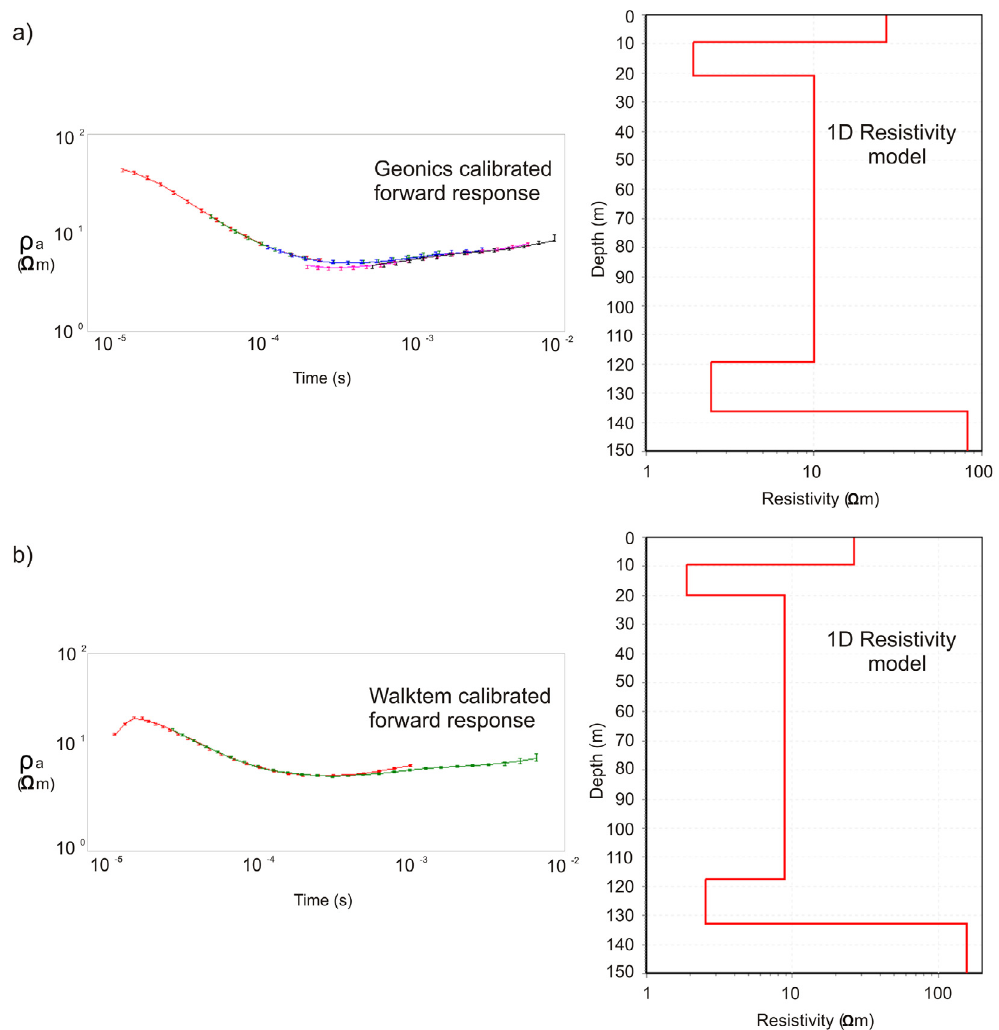
Figure 6. Field data (error bar), forward responses (solid line) and recovered 1-D resistivity models for the two calibrated (a) Geonics 47 and (b) WalkTEM instruments obtained at the Italian reference and calibration site for coincident coil position from a 50 × 50 m and 40 × 40 m loop size respectively.